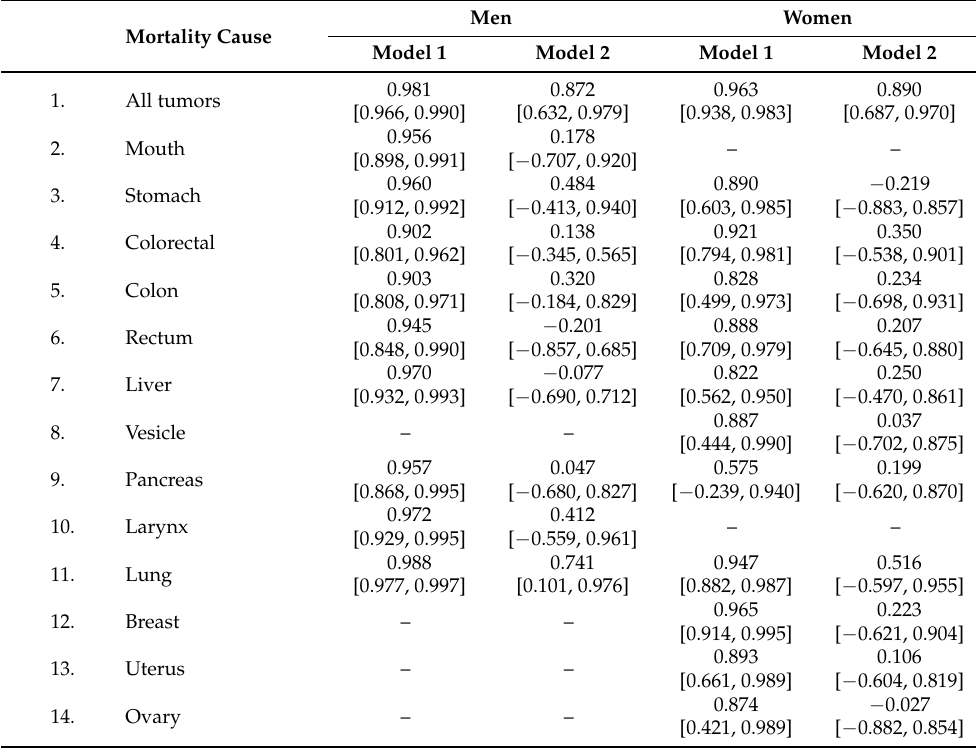
Table 2. Posterior mean and 95% credible interval for the temporal correlation coefficient ( ρ ) for each model. Model 1 refers to the original AR model in Martinez Beneito et al. (2008) [17], and Model 2 refers to the new model proposed in this